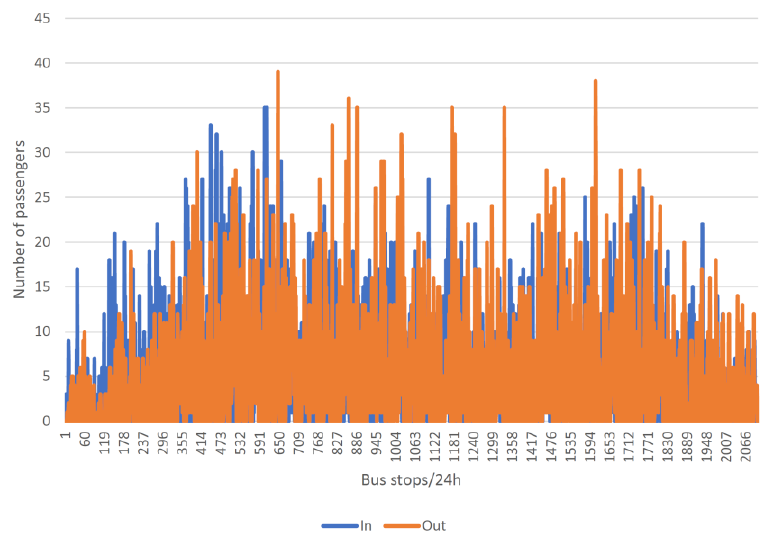
Figure 5. Passenger number dynamics for one day ’s operations of an electric bus.